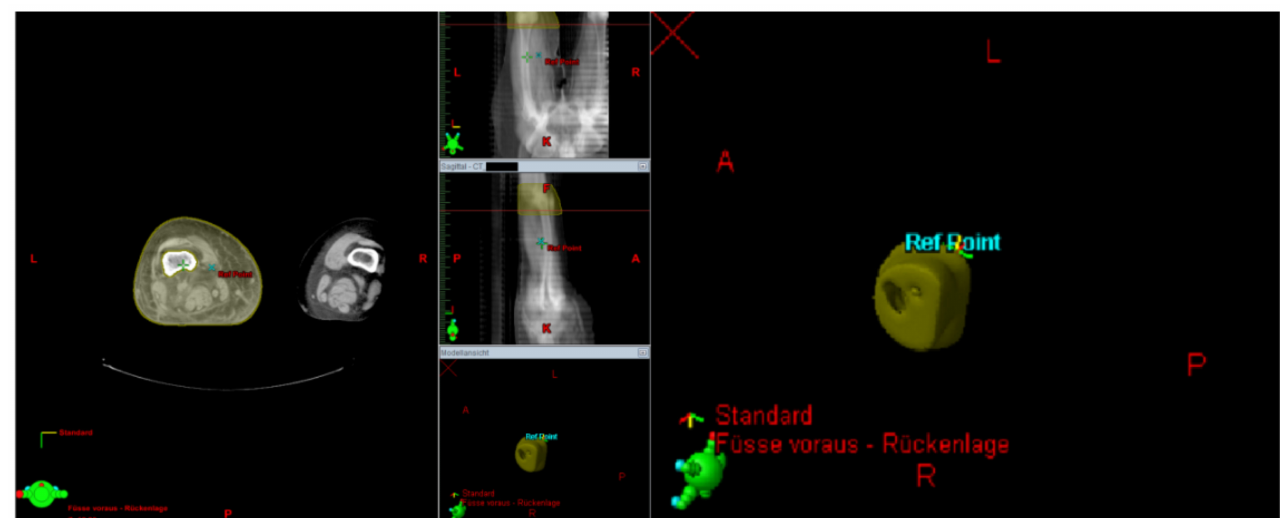
Figure 4. Subtracting the bone volume from the extremity volume.